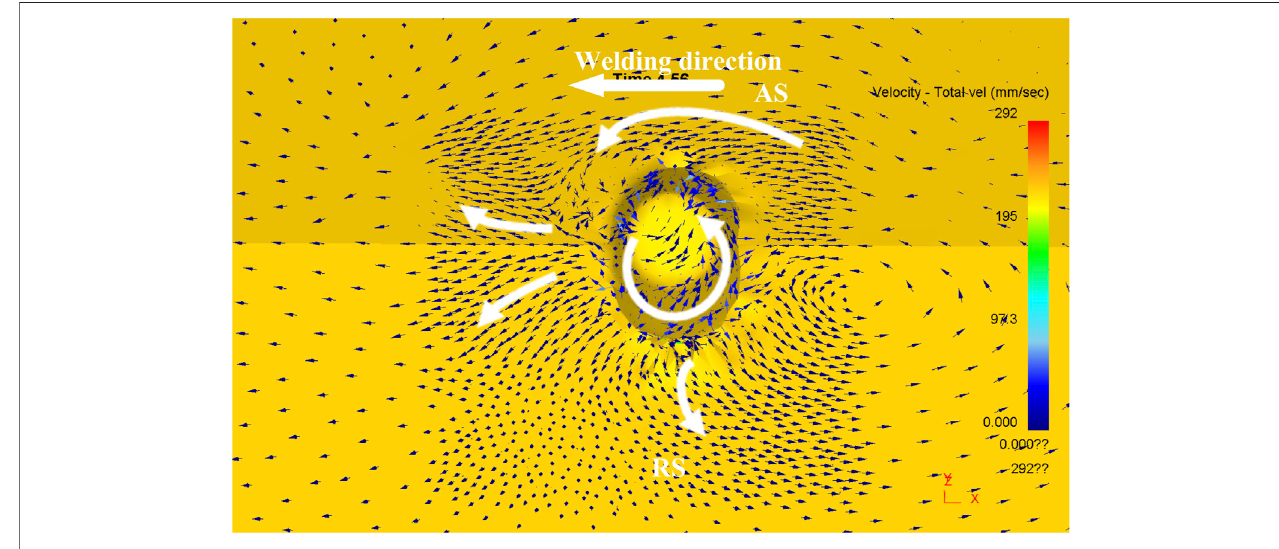
FIGURE 7 | Materials fl ow on the